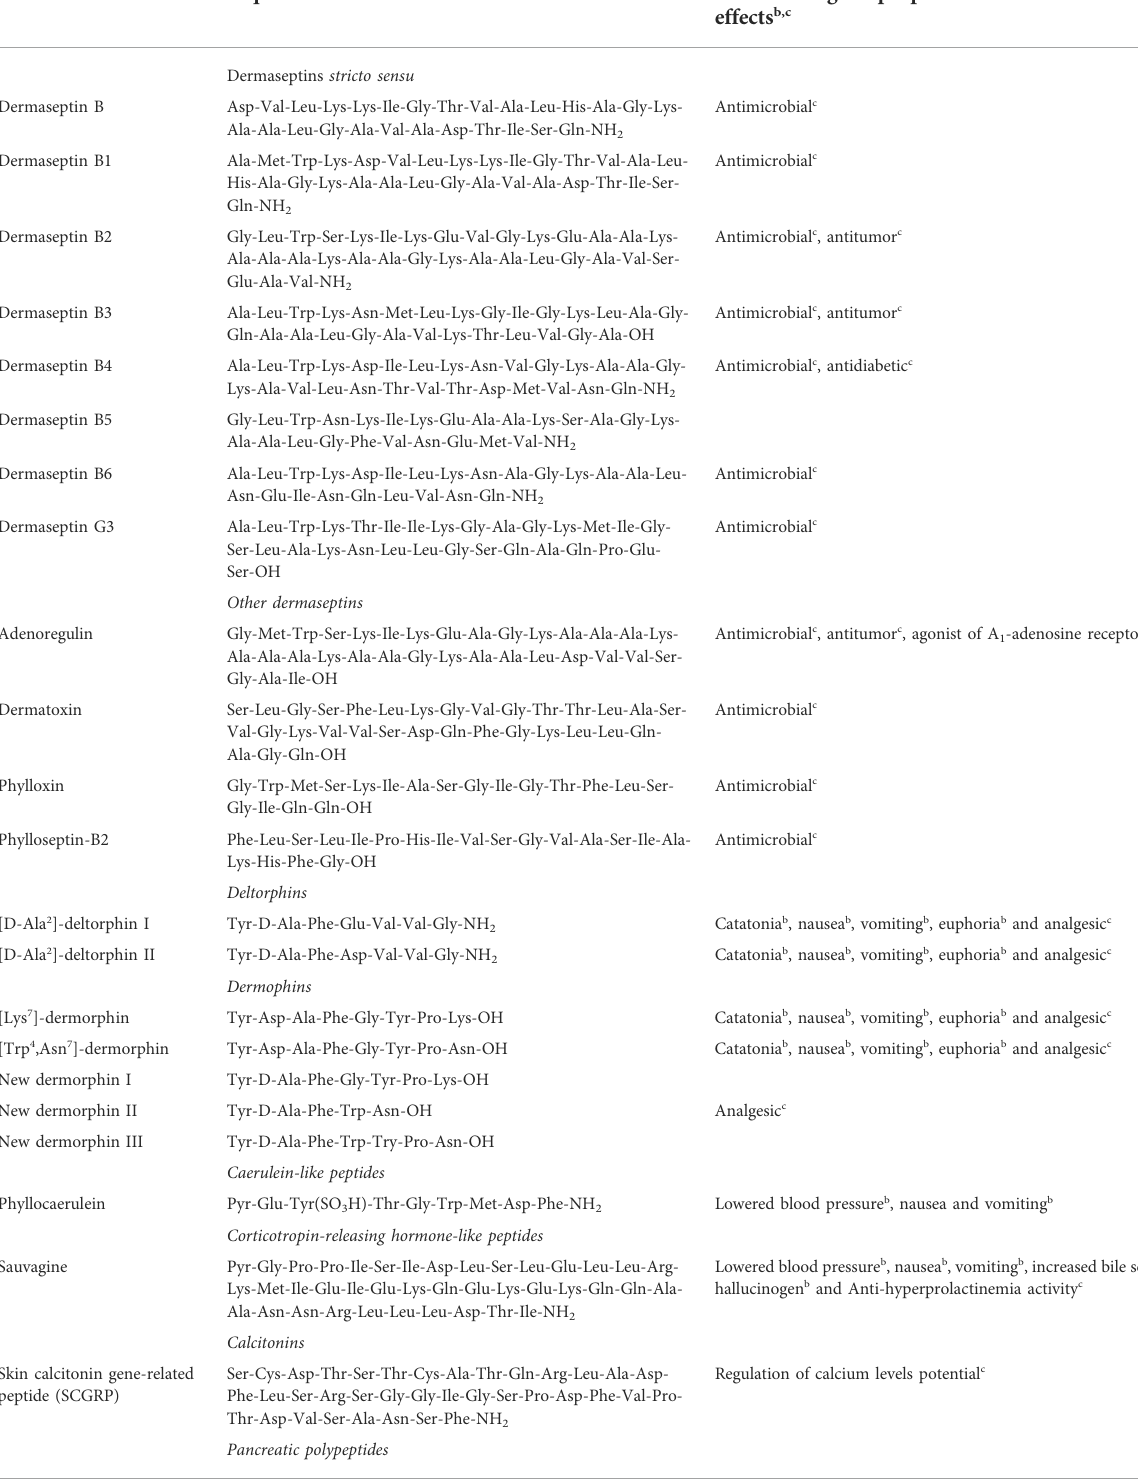
TABLE 1 Classi fi cation, sequence details and pharmacological activities and effects of peptides from Phyllomedusa bicolor